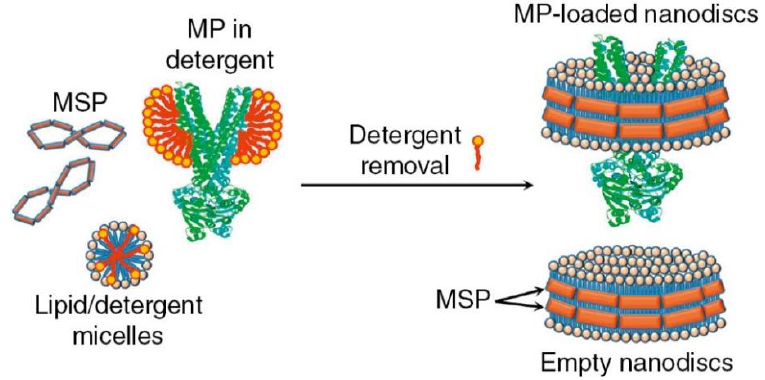
Figure 2. Traditional assembly of a nanodisc with a membrane protein (MP). Reproduced from [43]. MSP, membrane scaffold protein.